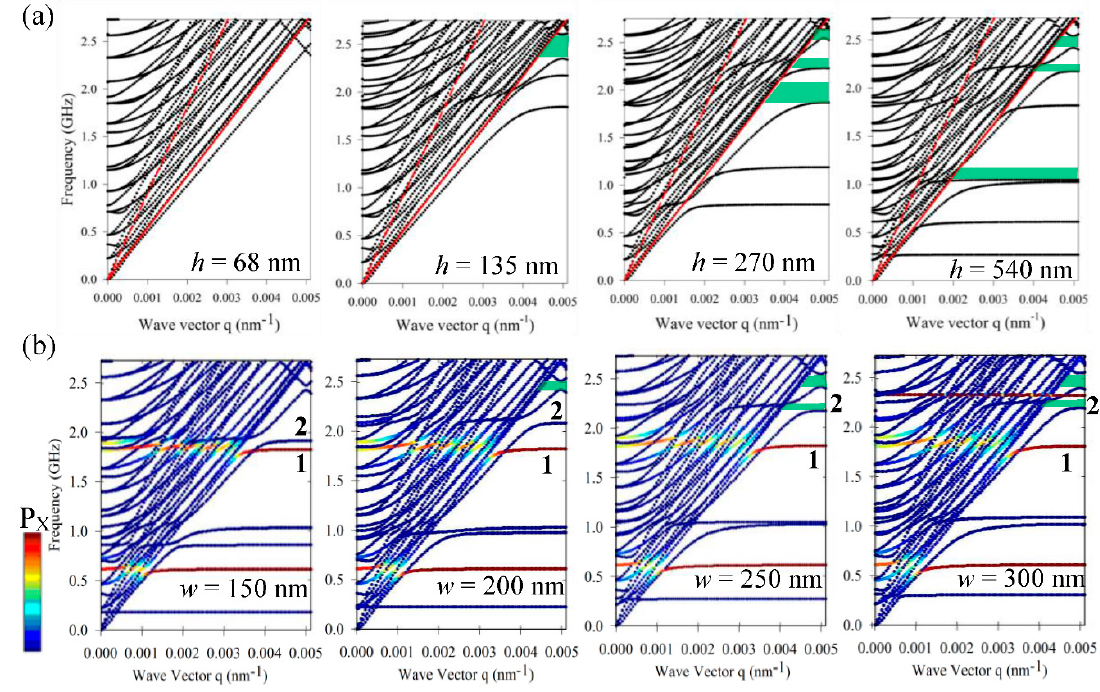
Figure 7. Evolution of the dispersion curves for propagation perpendicular to the ridges as a function of ( a ) the height with w = 250 nm and ( b ) the width with h = 540 nm.